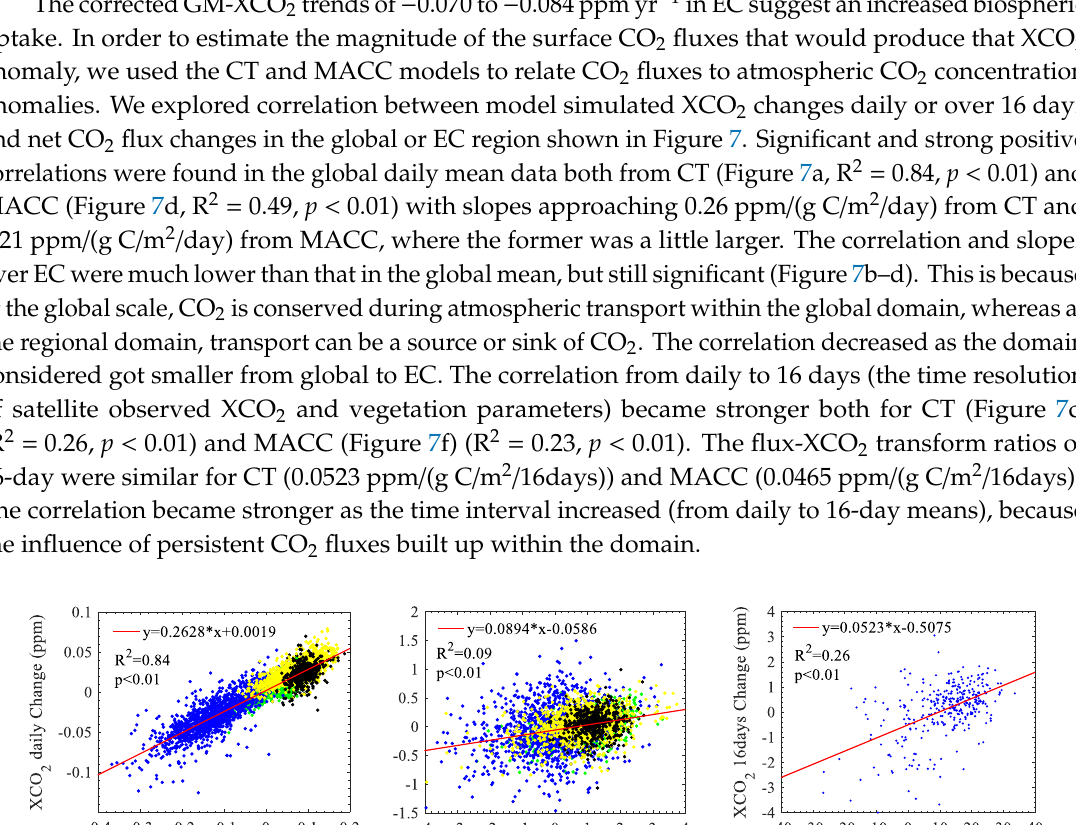
C/m 2 using the MACC transform ratio. That is basically consistent with GPP increase of 9.24 g C m −2 shown in Section 3.1. The total carbon uptake amount from 2003 to 2015 ranged from 28.41 to 46.04 Tg C with an EC region area of 4.47 × 10 12 m 2 shown in Figure S8.